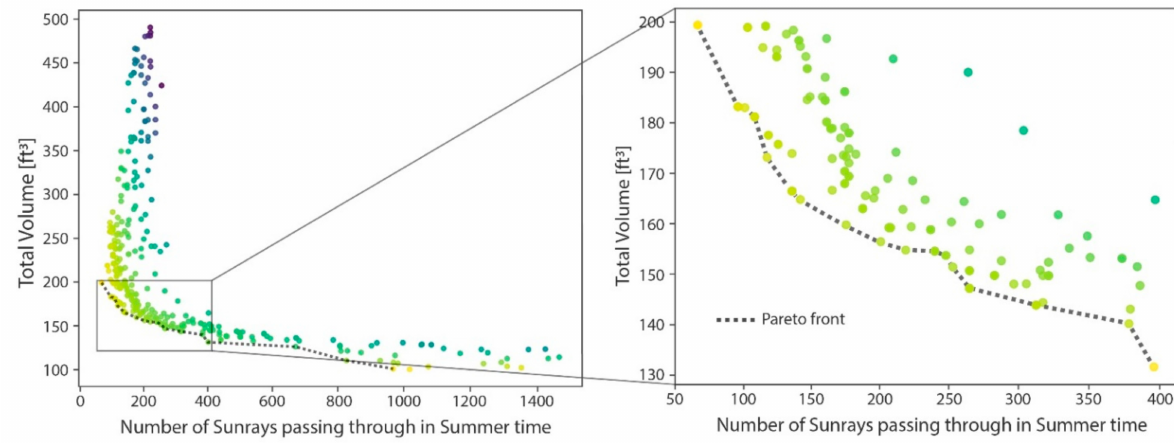
Figure 10. Pareto Front constructed on the analysis results.